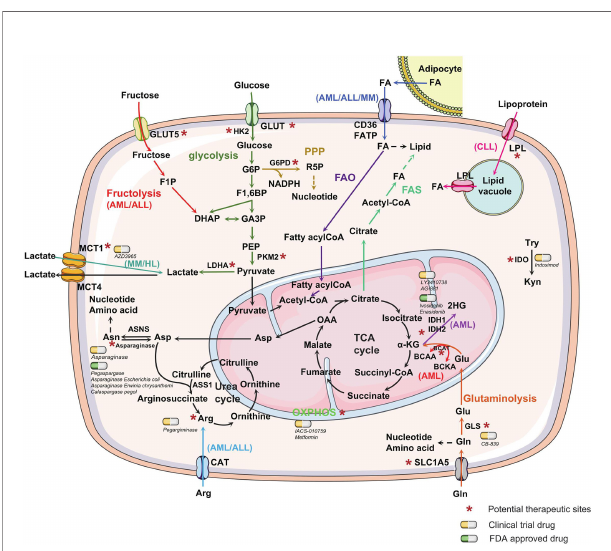
FIGURE 2 | Metabolic alterations in hematological malignancies. Metabolic alterations in hematological malignancies are mainly re fl ected in the increase in glucose and glutamine uptake and fatty acid metabolism to promote the rapid synthesis of nucleotides, proteins, and lipids. Different metabolic pathways are marked with distinct colors. Unique metabolic characteristics exhibited in one or a few types of hematological malignancies are labeled. Some special enzymes or reaction processes in the metabolic process, which can be used as potential therapeutic targets, are marked with an asterisk. The yellow capsules represent the drugs in clinical trials, whereas the green capsules represent FDA-approved drugs targeting the metabolic process of hematological malignancies. The dashed line with arrow represents anabolism. GLUT, glucose transporter; HK2, hexokinase2; G6P, glucose-6- phosphate; G6PD, Glucose-6-phosphate dehydrogenase; R5P, ribose-5- phosphate; PPP, pentose phosphate pathway; NADPH, nicotinamide adenine dinucleotide phosphate; F1,6BP, fructose-1,6-biphosphate; GA3P, glyceraldehyde 3-phosphate; DHAP, dihydroxyacetone phosphate; F1P, fructose-1-phosphate; PEP, phosphoenolpyruvate; PKM2, pyruvate kinase M2; FA, fatty acid; FATP, fatty acid transport protein; OAA, oxaloacetate; a - KG, a -ketoglutarate; Asp, Asparagine; Asn, asparagine; ASNS, asparagine synthetase, ASS1, arginine succinate synthase-1; Arg, arginine; CAT, cationic amino acid transporters; BCAA, branched-chain amino acid; BCKA, branched-chain Keto acid; IDH, isocitrate dehydrogenases; 2HG, 2- hydroxyglutarate; Glu, Glutamate; Gln, glutamine; GLS, glutaminase; Try, tryptophan; Kyn, kynurenine; IDO, indoleamine 2,3-dioxygenase, LPL, lipoprotein lipase; MCT, monocarboxylate transporter; LDHA, lactate dehydrogenase A; FAO, fatty acid oxidation; FAS, fatty acid synthesis; TCA, tricarboxylic acid